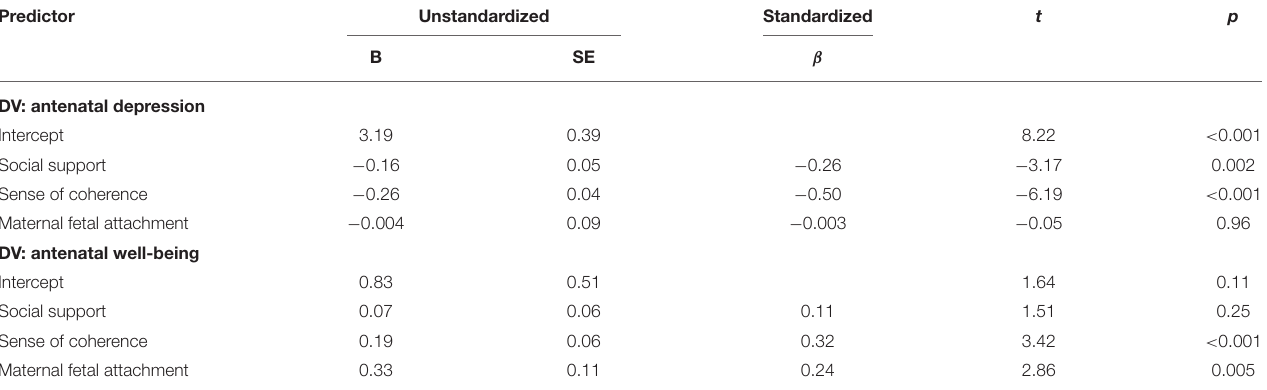
TABLE 4 | Coefficient estimates for regression models. Predictor Unstandardized